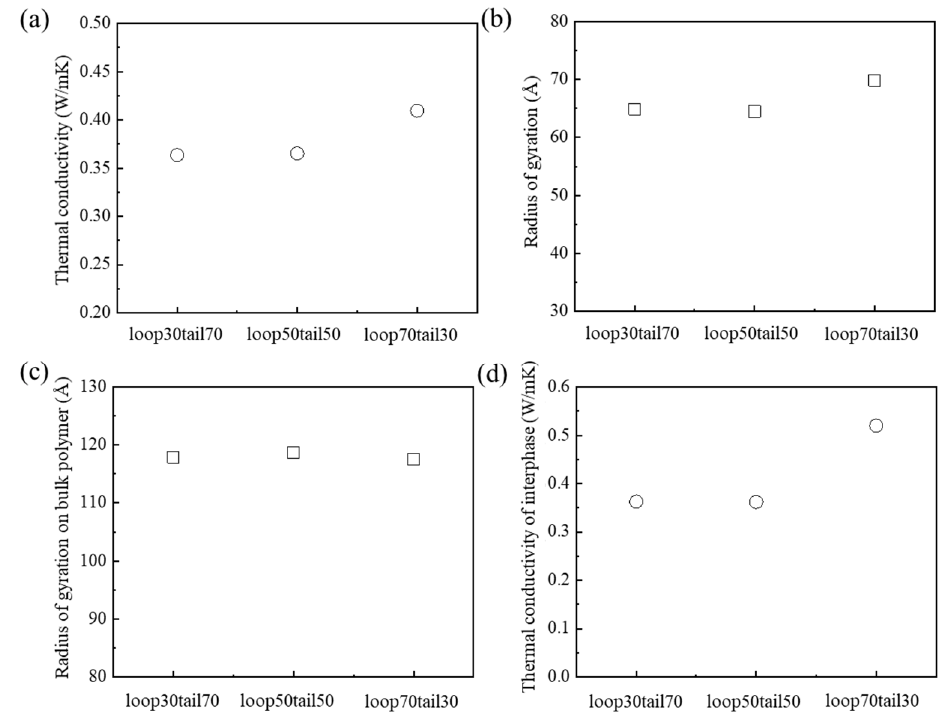
Figure 4. Thermal transport according to the ratio of loop and tail conformations: ( a ) thermal conductivities, ( b ) radius of gyration, ( c ) radius of gyration on the bulk polymer, and ( d ) thermal conductivities of interphase.